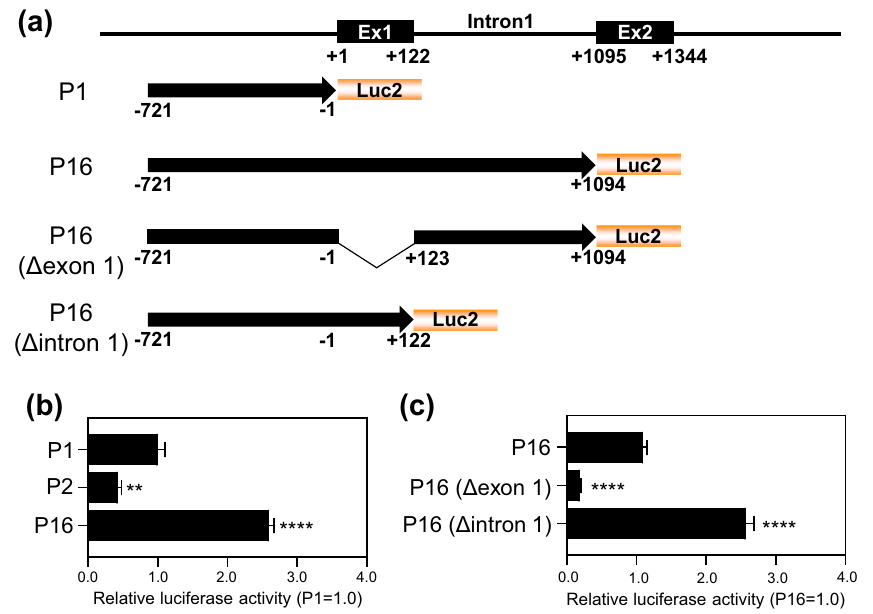
Figure 4. TARDBP exon 1 is crucial for upstream promoter activity. ( a ) Schematic representation of P16 (− 721/+ 1094), P16 (Δexon 1) and P16 (Δintron 1). ( b ) Luciferase assay of P1 (upstream promoter), P2 (intron 1 promoter) and P16. n = 3 replicates; one-way ANOVA with post hoc Dunnett’s test relative to P1. ( c ) Luciferase assay of P16, P16 (Δexon 1) and P16 (Δintron 1). n = 3 replicates; one-way ANOVA with post hoc Dunnett’s test relative to P16. All error bars indicate the means ± SEMs. ** P < 0.01, **** P <